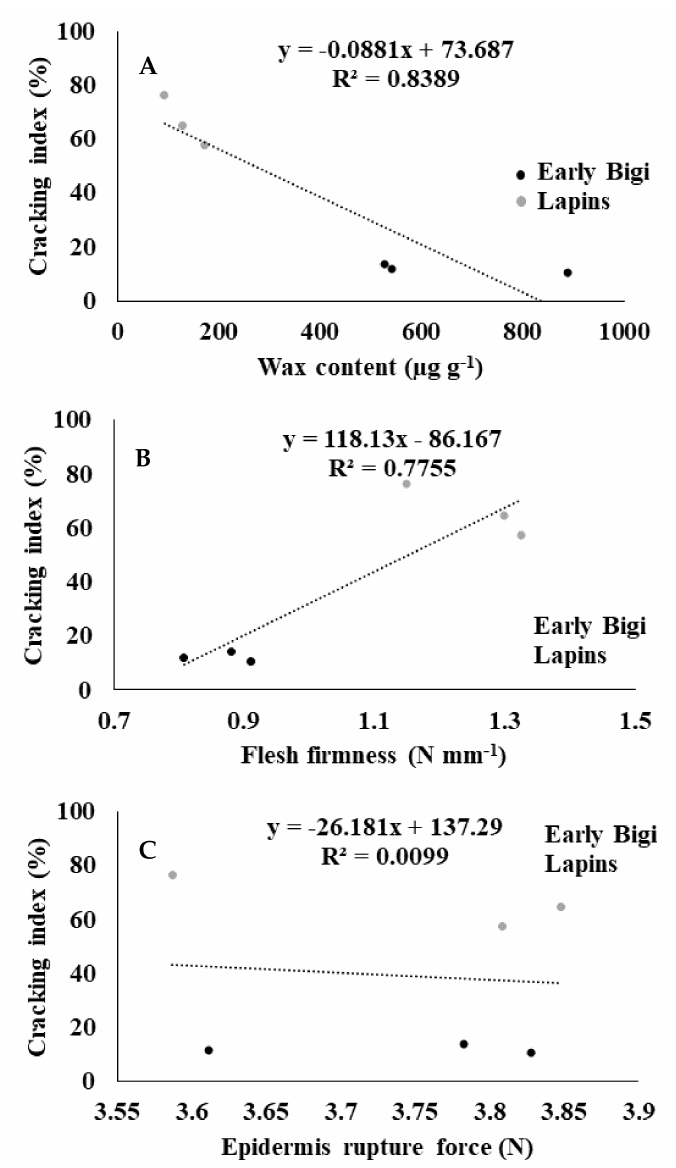
Figure 4. Correlations between ( A ) the cracking index (%) and the wax content ( µ g g − 1 ), ( B ) the cracking index (%) and the flesh firmness (N mm − 1 ), and ( C ) the cracking index (%) and the epidermis rupture force (N) of two sweet cherry cultivars: Early Bigi and